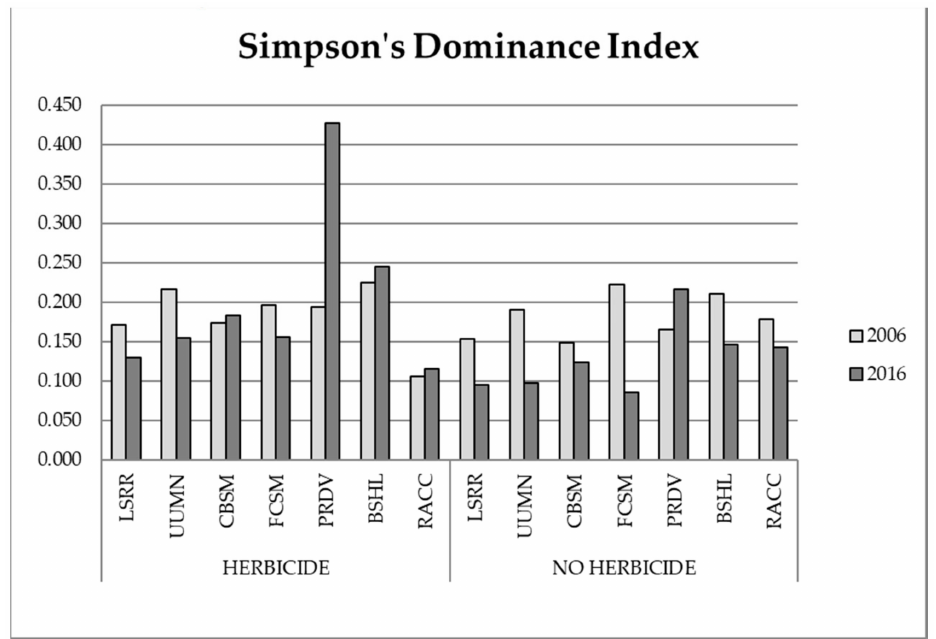
Figure 6. Assessment by Simpson’s dominance index for the plant communities in the herbaceous covers under treatment with and without herbicide in the two time intervals